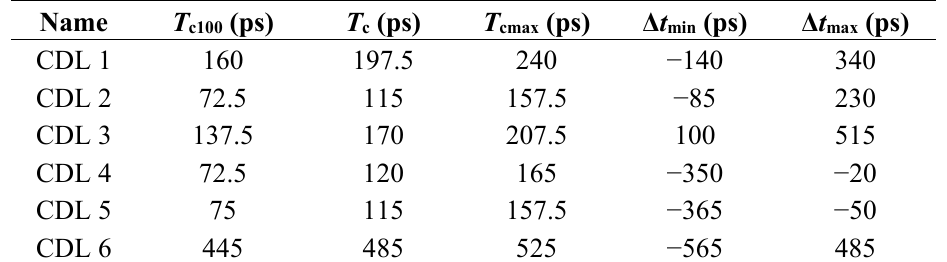
Table 2. Coincidence window times and timing characteristics of different CDL